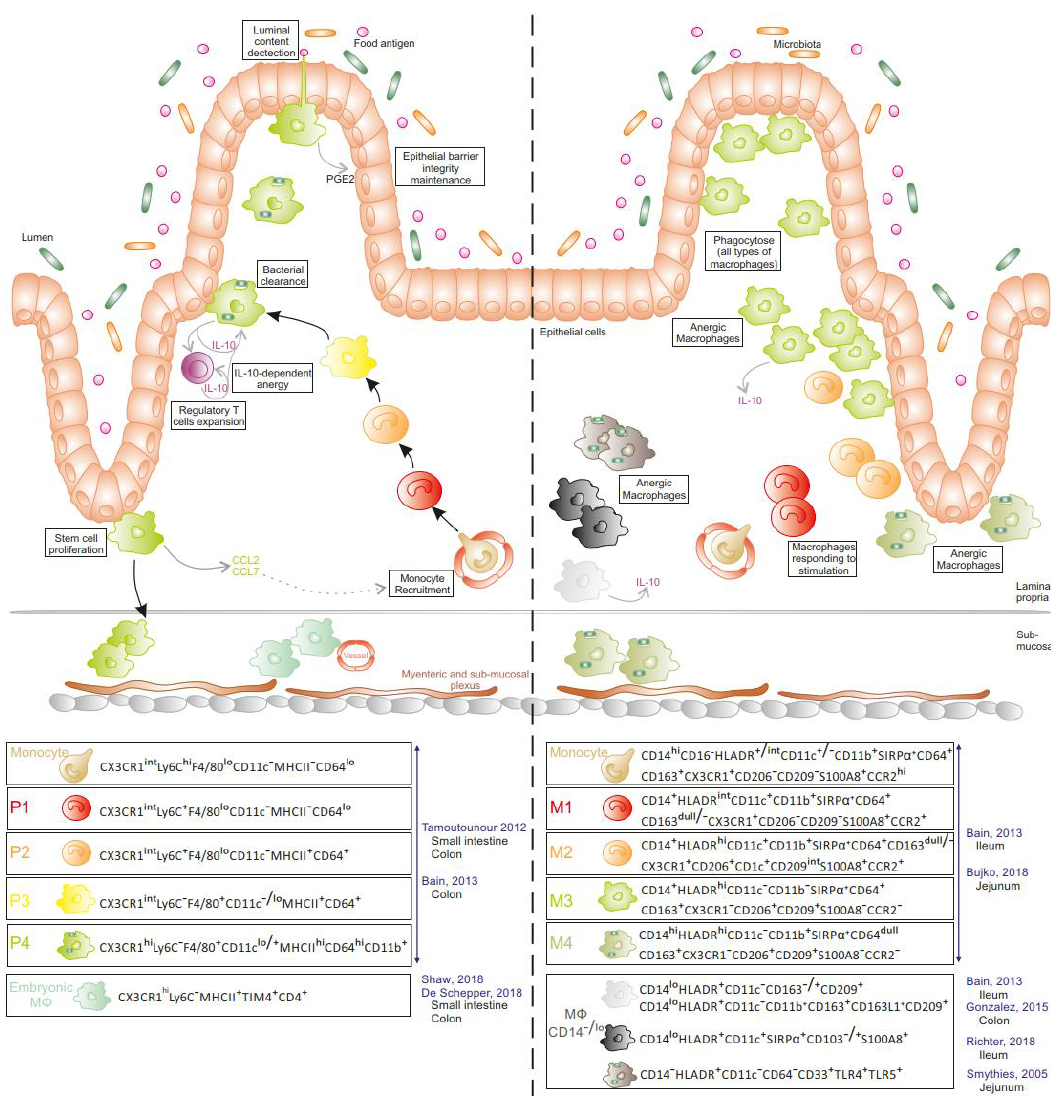
Figure 3. Intestinal monocyte/macrophage populations at steady state in mice and humans. In mice (left panel), the majority of M ɸ derive from circulating monocytes. Once recruited in tissue, monocytes undergo a maturation process into anergic M ɸ (P1 to P4), producing and responding to IL-10 and ensuring diverse functions in the lamina propria. Embryonic M ɸ are located in the submucosa. In humans (right panel), monocyte derived-M ɸ (M1 to M4), the potential counterparts of murine mononuclear phagocytes (MNPs) and several anergic M ɸ subsets have been reported in the lamina propria. (Literature cited in blue along with gut location).